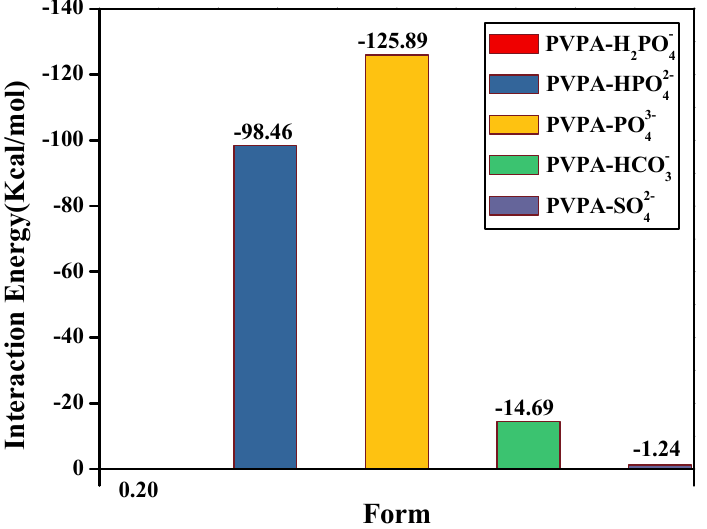
Figure 7. Energies of the interactions of the introduced anions with the PVPA chain. When the introduced anion was HCO (cid:2871)(cid:2879) , its interaction energy with the PVPA chain was − 14.67 Kcal/mol. The minimum distance of HCO (cid:2871)(cid:2879) to the PVPA chain was 1.532 A(cid:4662) , as shown in Figure 6e. The oxygen atom attached to the double bond is likely to form hydrogen bonds with the hydrogen atom in the phosphoric acid at the end of the PVPA chain. The formation of the hydrogen bond causes the interaction energy of HCO (cid:2871)(cid:2879) with the PVPA molecular chain to be larger than that of H (cid:2870) PO (cid:2872) (cid:2879) with the PVPA molecular chain. In other words, the adsorption degree of HCO (cid:2871)(cid:2879) on the PVPA surface is greater than that of H (cid:2870) PO (cid:2872)(cid:2879) . Theoretically, the adsorption amount of HCO (cid:2871)(cid:2879) on the PVPA surface should be larger than that of H (cid:2870) PO (cid:2872)(cid:2879) , while the result was just the opposite. Since HCO (cid:2871)(cid:2879) and H (cid:2870) PO (cid:2872)(cid:2879) have the same number of charges and double bonds, such contrary conclusion is speculated to be caused by the structural difference of the anions. HCO (cid:2871) (cid:2879) is a planar structure. The oxygen atoms at the end of the double bond are 2.253 and 2.285 A(cid:4662) away from the other two oxygen atoms. The distance between the oxygen atom at the end of the C-O single bond and the hydrogen atom is 2.226 A(cid:4662) . The length of the O-H single bond is 0.975 A(cid:4662) . Assuming that an HCO (cid:2871) (cid:2879) is completely adsorbed on the PVPA surface, its corresponding adsorption area is 0.0330 nm 2 . The structure of H (cid:2870) PO (cid:2872) (cid:2879) is regular tetrahedral, and the ad- sorption area S of a single H (cid:2870) PO (cid:2872)(cid:2879) can be calculated as follows: 𝑆 = √3 4 ∗ (2𝐿 ∗ 𝑠𝑖𝑛 𝜃 2) (cid:2870) (3) where L = 0.16 nm is the bond length of P-O bond, and θ = 109.5° is the bond angle between O–P–O. The adsorption area of an H (cid:2870) PO (cid:2872)(cid:2879) on the PVPA surface is 0.0296 nm 2 . Under the combined action of the adsorption degree and adsorption area of anions on the PVPA surface, the adsorption amount of HCO (cid:2871)(cid:2879) on PVPA surface is less than that of H (cid:2870) PO (cid:2872)(cid:2879) , re- sulting in the sudden decrease in degree of the COF induced by HCO (cid:2871) (cid:2879) to be less than that of H (cid:2870) PO (cid:2872)(cid:2879) . When the introduced anion was SO (cid:2872)(cid:2870)(cid:2879) , its interaction energy with PVPA chain was − 1.24 Kcal/mol, as shown in Figure 7. In contrast to HPO (cid:2872)(cid:2870)(cid:2879) , SO (cid:2872)(cid:2870)(cid:2879) contains two double bonds due to central atomic differences. It can be speculated that the higher the number of double bonds in anions, the lower the interaction between anions and the PVPA mo- lecular chain, the lower the adsorption number of anions on the PVPA surface, and the smaller the decrease in the degree of the COF. The results showed that for anions carrying different numbers of charges, the more charge they carry, the more likely they are to form hydrogen bonds with the PVPA